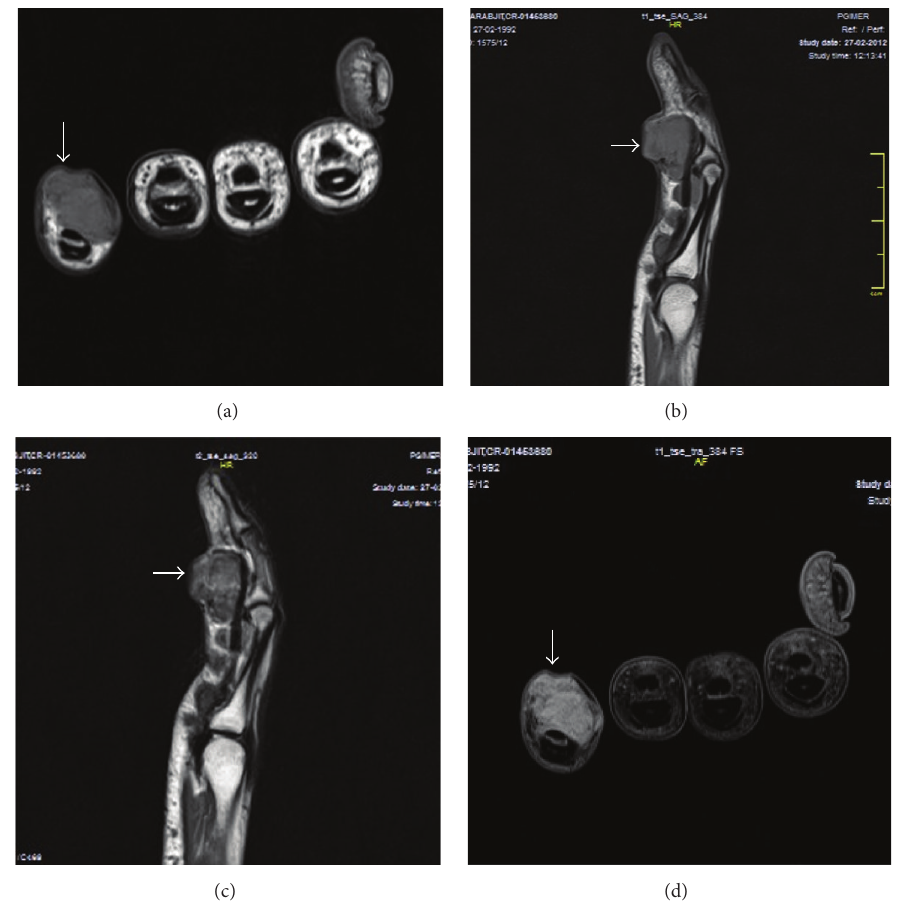
Figure 4: Giant cell tumor of tendon sheath. MRI (of the same patient as in Figure 3) show multiple, well-defined, lobulated, T1W, and T2W hypointense lesions ((a)–(c)) along the flexor tendons of right 5th finger. These lesions show mild enhancement seen on postgadolinium T1FS images